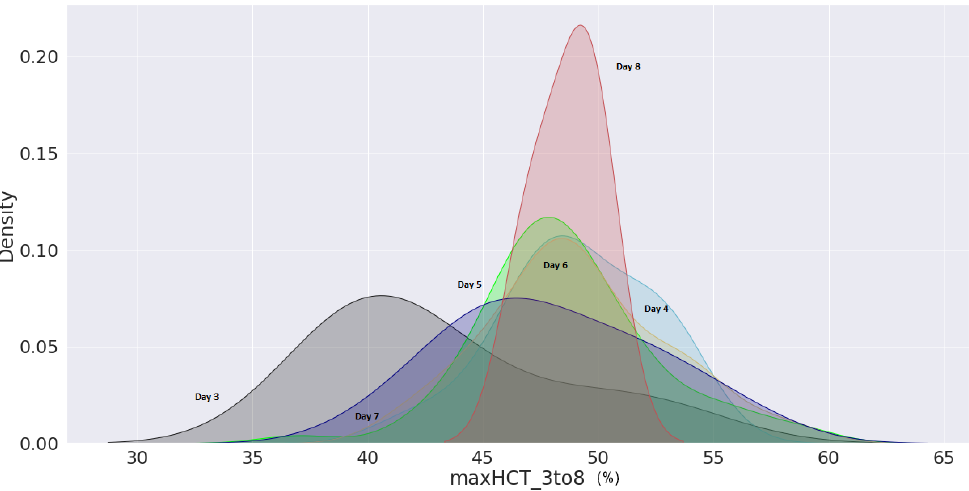
Figure 20. Maximum haematocrit concentration of shock victims as plotted each day since enrolment to the hospital using kernel density estimation